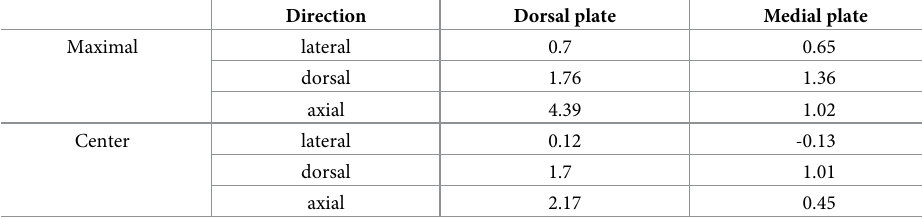
Table 2. Comparison of maximal relative displacements [mm] between bone surfaces at the MTP1 joint for a resultant force of 150 N. The relative bone translations were also computed in the center of the proximal phalanx